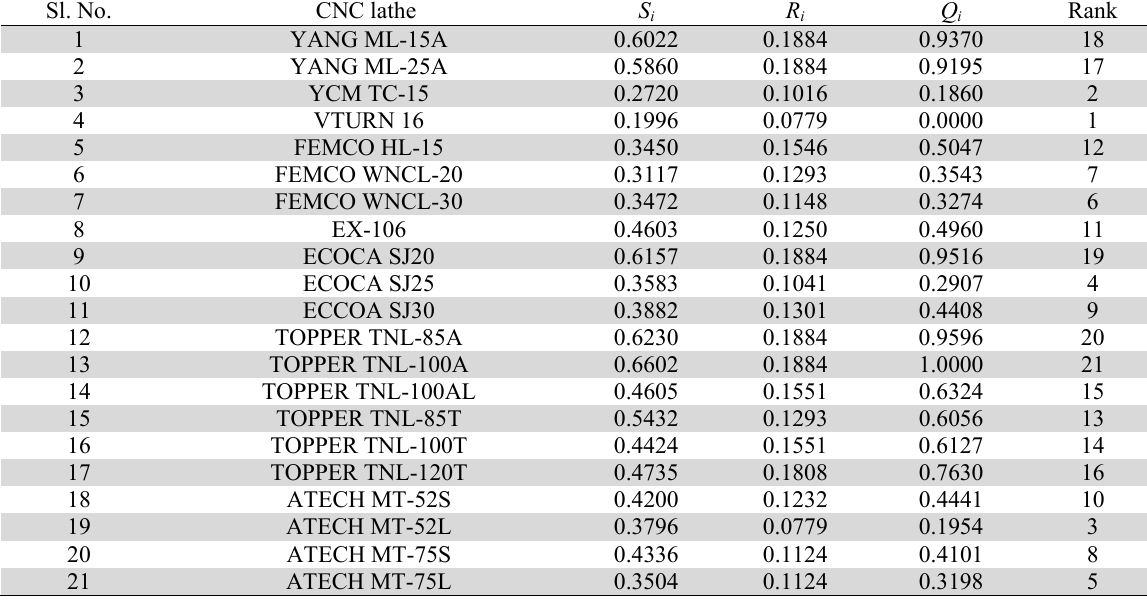
Ranking of CNC machine tools using original VIKOR method Sl.